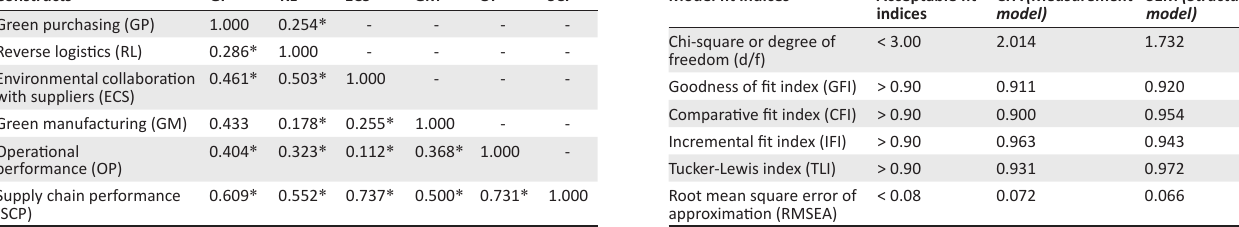
TABLE 3: Model fit statistics. TABLE 2: Correlations between constructs.